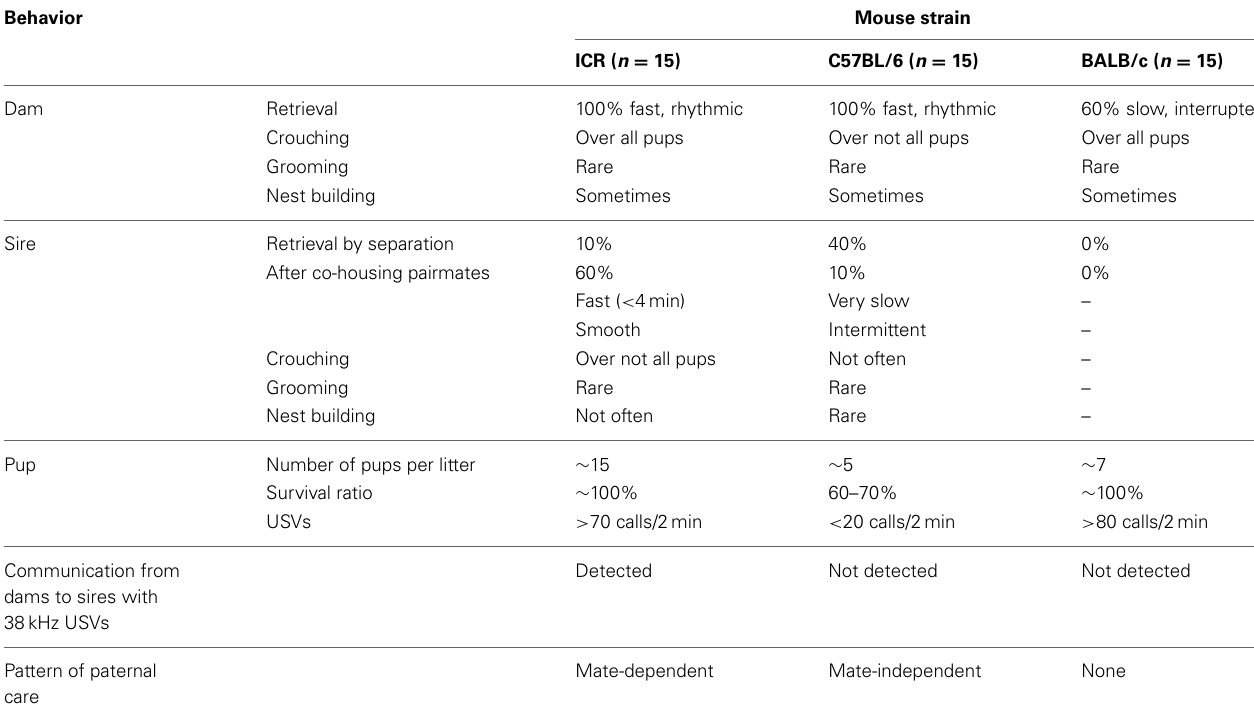
Table 1 | Parental behaviors in three strains of